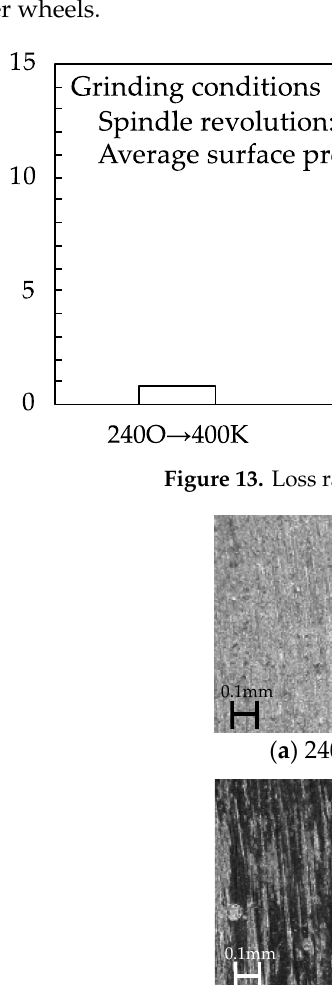
Figure 12. Arithmetic average height of the assessed profile of the steel sheet after the semi-finish grinding.